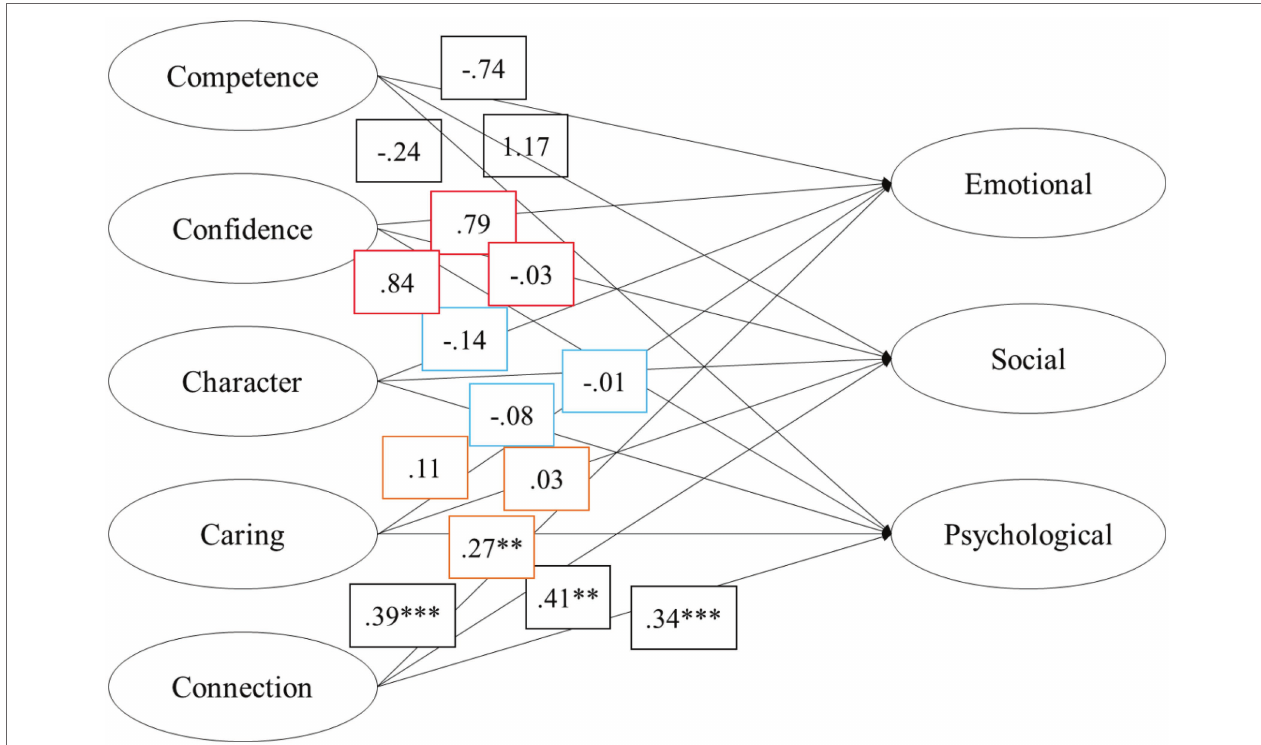
FIGURE 1 | Visual representation of the structural equation model estimating the relations between the 5Cs of PYD and the MHC factors. Model Fit Indices, χ 2 ( df ) = 2323.730 (870); RMSEA (90% CI) = 0.053 (0.051–0.056); CFI/TLI = 0.899/0.885; a standardized coefficient results controlling for age and gender. ** p < 0.001; *** p <